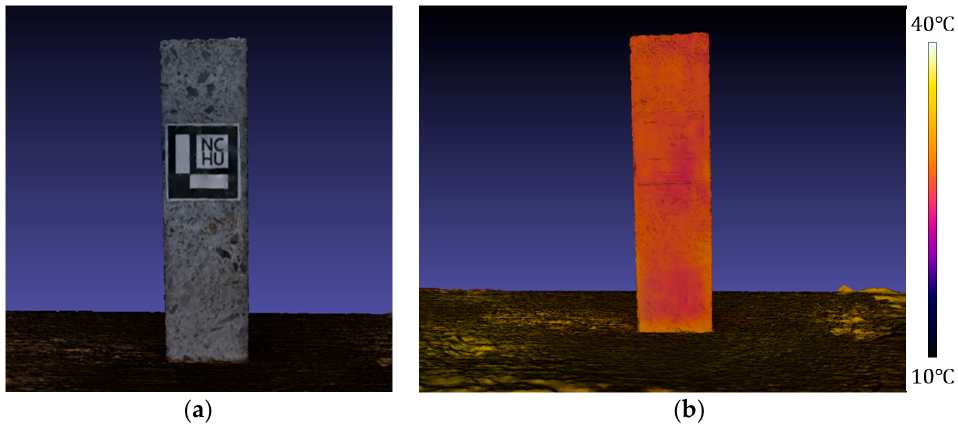
Figure 7. Model reconstruction of small scale scene: ( a ) 3D model of concrete sample; ( b ) 3D thermal model of concrete sample.